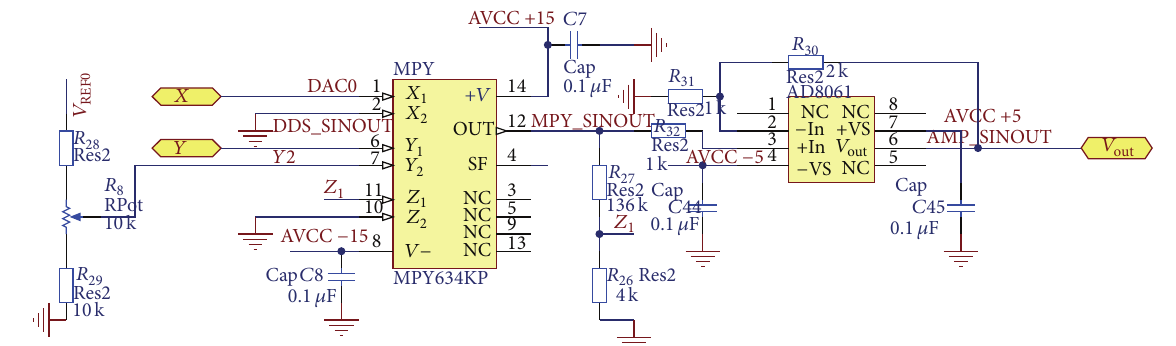
Figure 7: The circuit of wave generator.